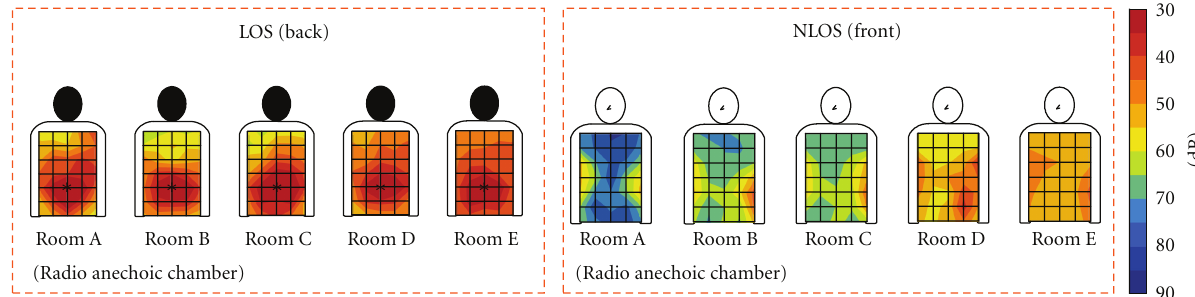
(Radio anechoic chamber)